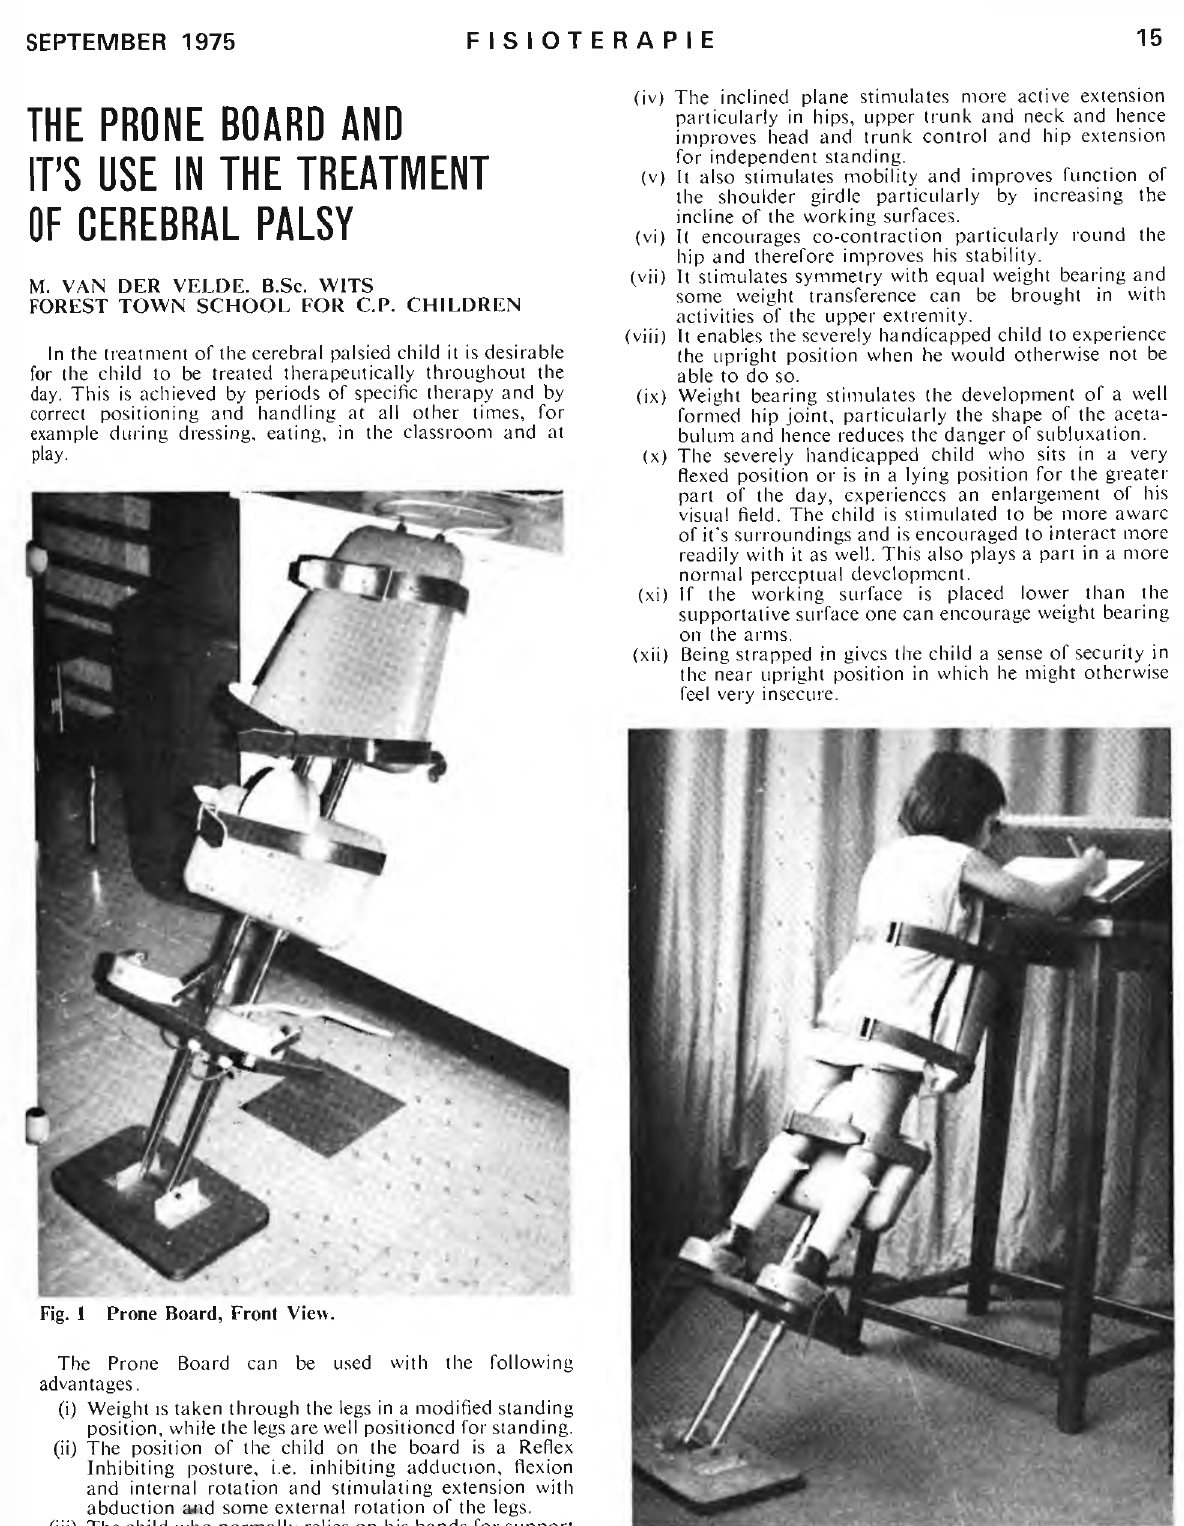
Fig. 2 Spastic Child on Prone Board: can only stand in a flexed, supported standing position; sits in wheelchair all